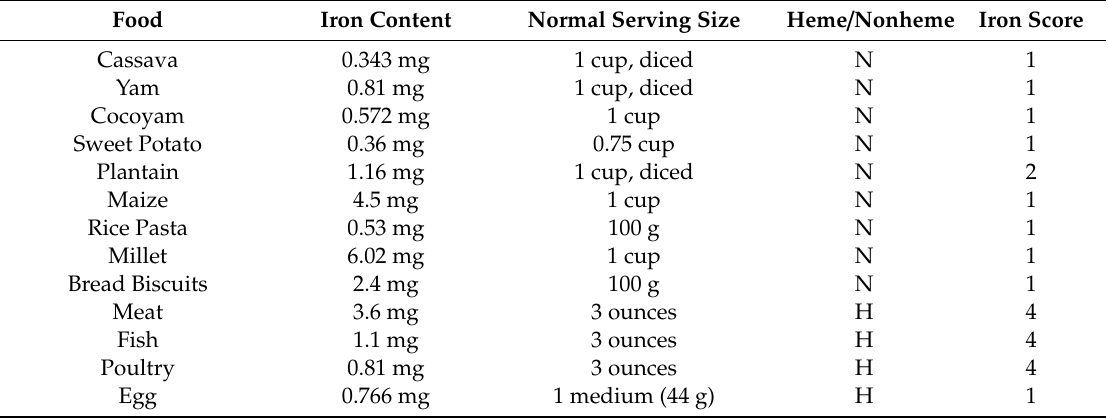
Figure 1. Correlation between hemoglobin and iron score. A moderate positive association was observed between hemoglobin circulating levels and participants iron consumption score n = 140, R = 0.42 and p = 8 × 10 − 5 . Table 3. Iron content and score value assigned to each food in the food frequency